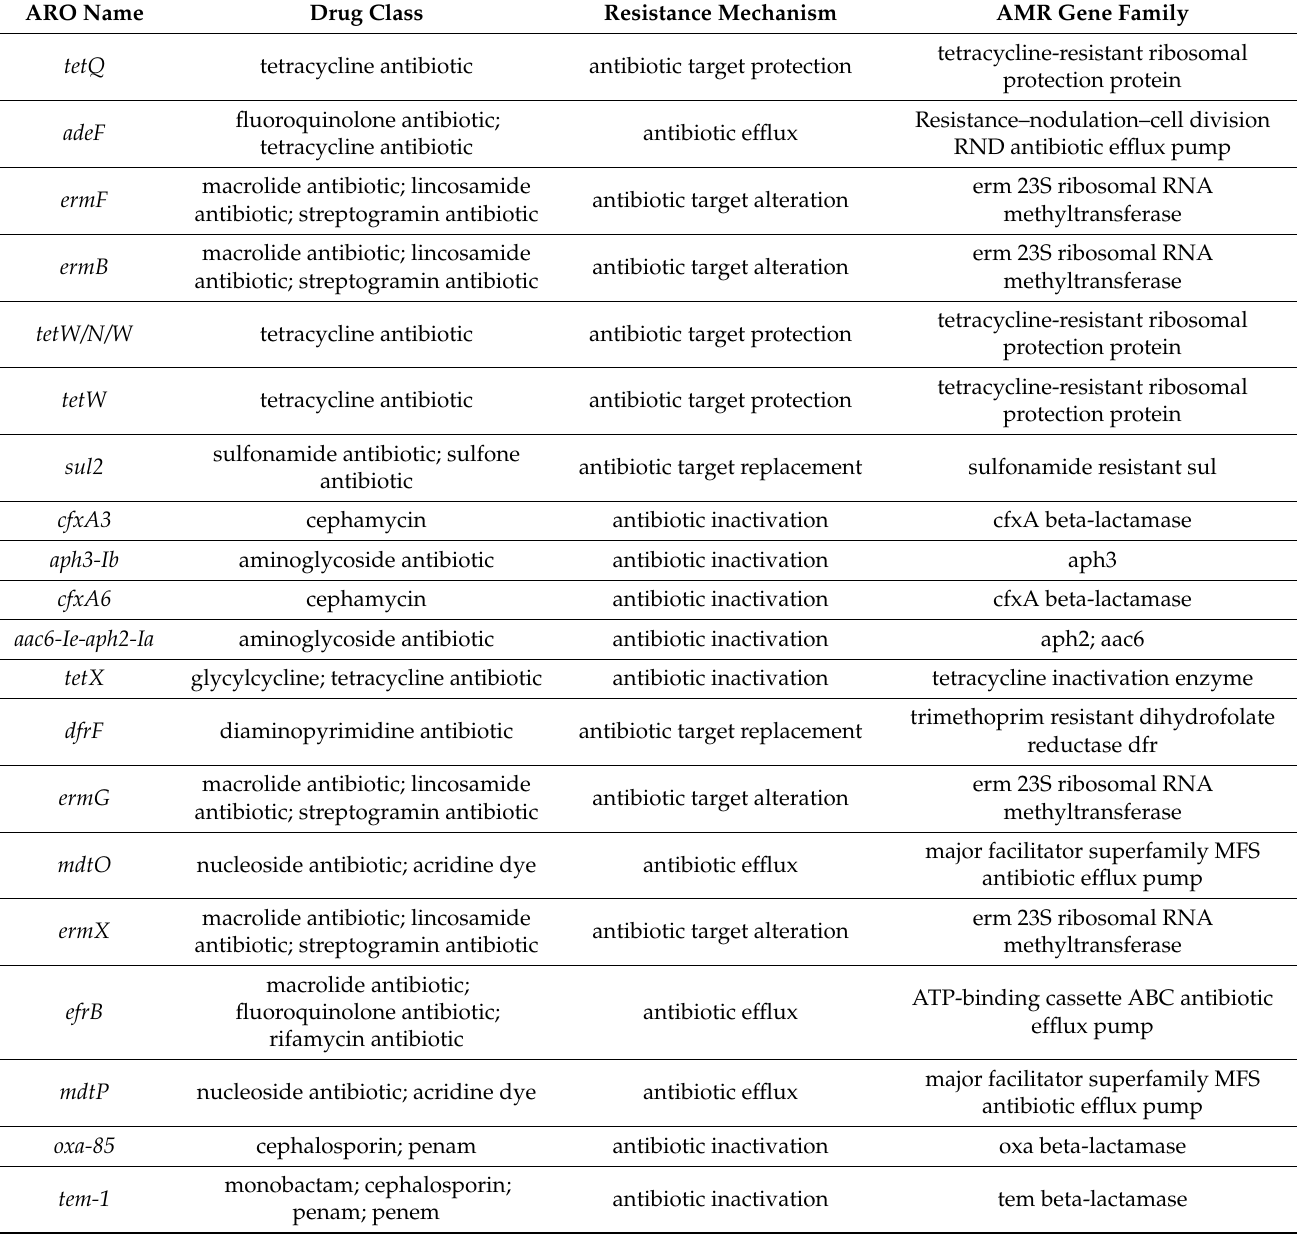
Table 1. Top 20 antibiotic resistance genes in the gut